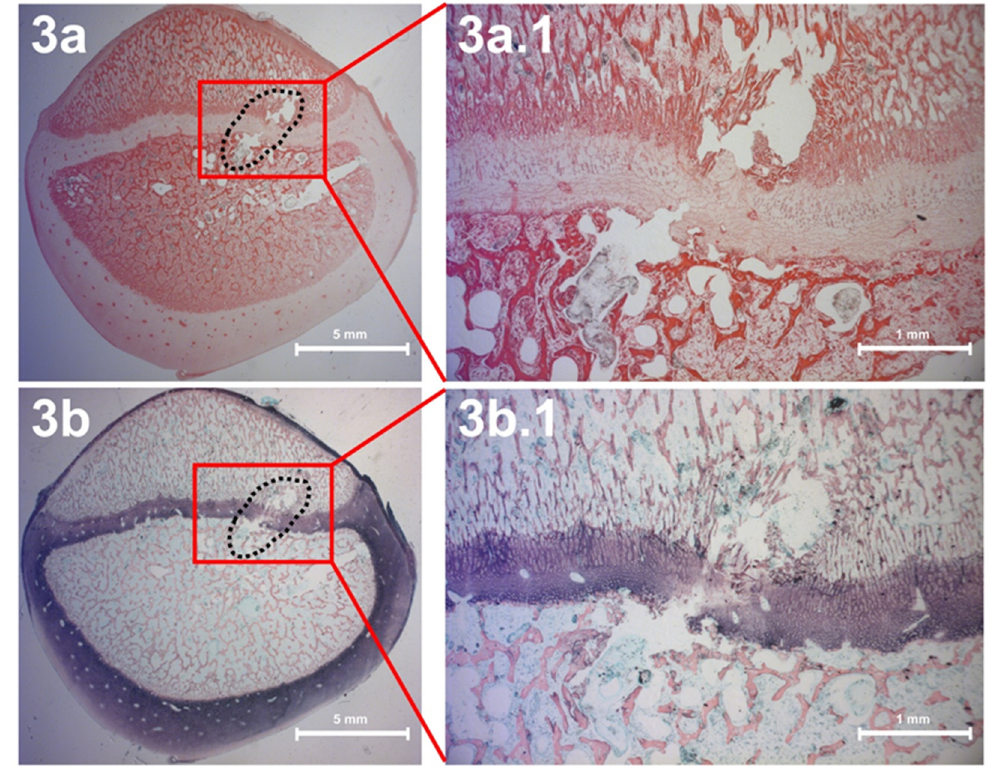
Figure 3. Sagittal section showing thermal lesions after electrocautery on the left side of the proximal tibia using H&E staining ( a ) and van Gieson staining ( b ). ( a ) The black dotted line shows thermal ablation lesion channel. The red box shows the magnification of the lesion channel ( a : scale bar 5 mm; a.1 : enlargement, scale bar 1 mm). ( b ) The same sectioning in van Gieson staining. The black dotted line shows the lesion channel. The red box shows the magnification of the lesion channel ( b : scale bar 5 mm; b.1 : enlargement, scale bar 1 mm).